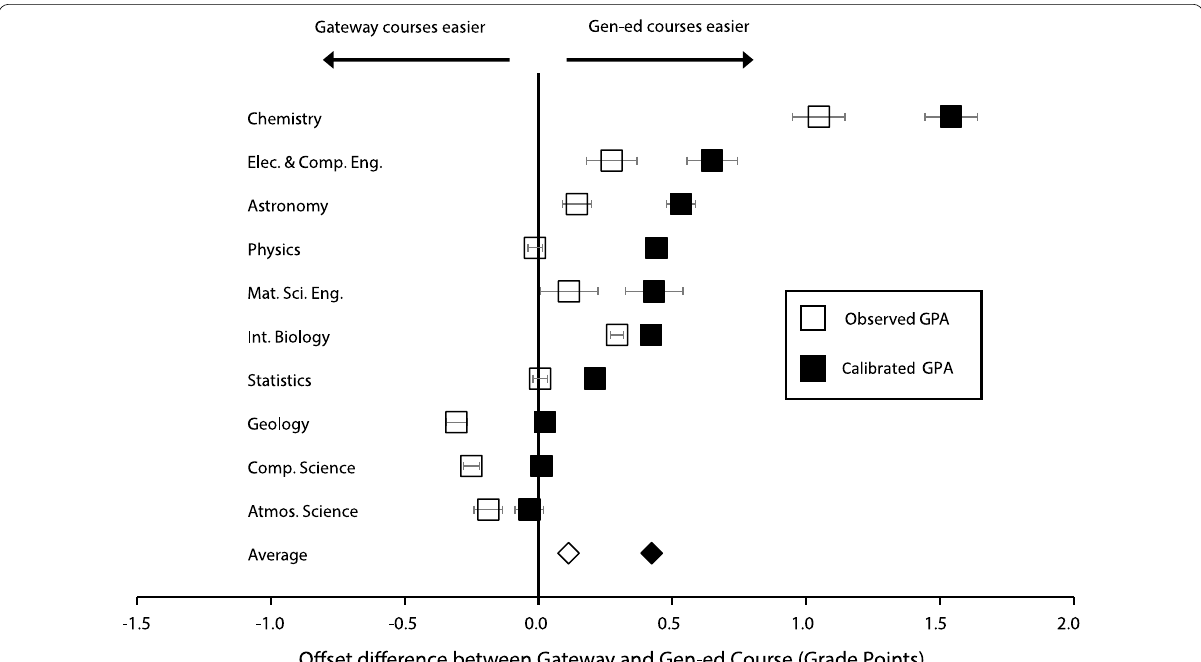
Fig. 5 Average grading difference between general education and gateway courses within ten STEM departments. A grade difference of 1.0 is equivalent to a letter grade. Positive values indicate that the gateway course was graded more stringently than the general education course. Open squares represent the grade offset calculated using the observed GPA. Black squares represent the grade offset calculated using the calibrated GPA. Error bars display 1 S.E. Diamonds are the weighted average of the ten departments ±